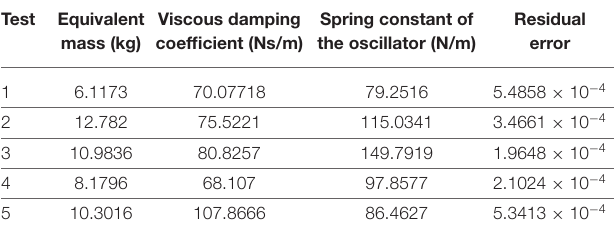
TABLE 1 | Characterization of pendular impacts according to the damped-mass spring